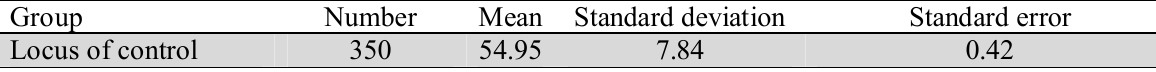
Group Locus of control